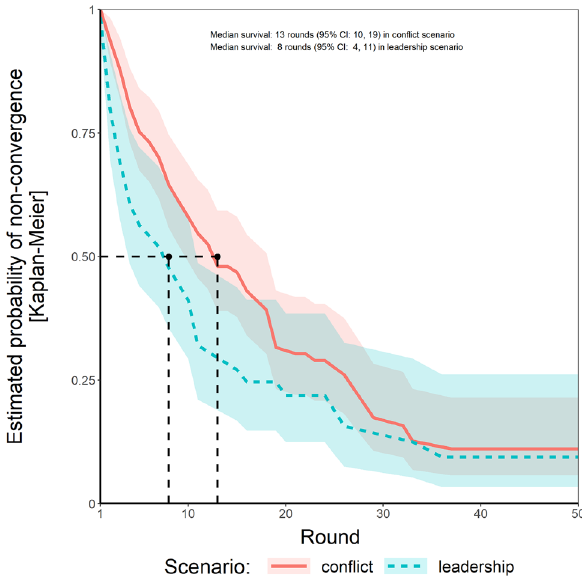
Figure 2. Consensus speed by scenario. Shaded areas represent 95%